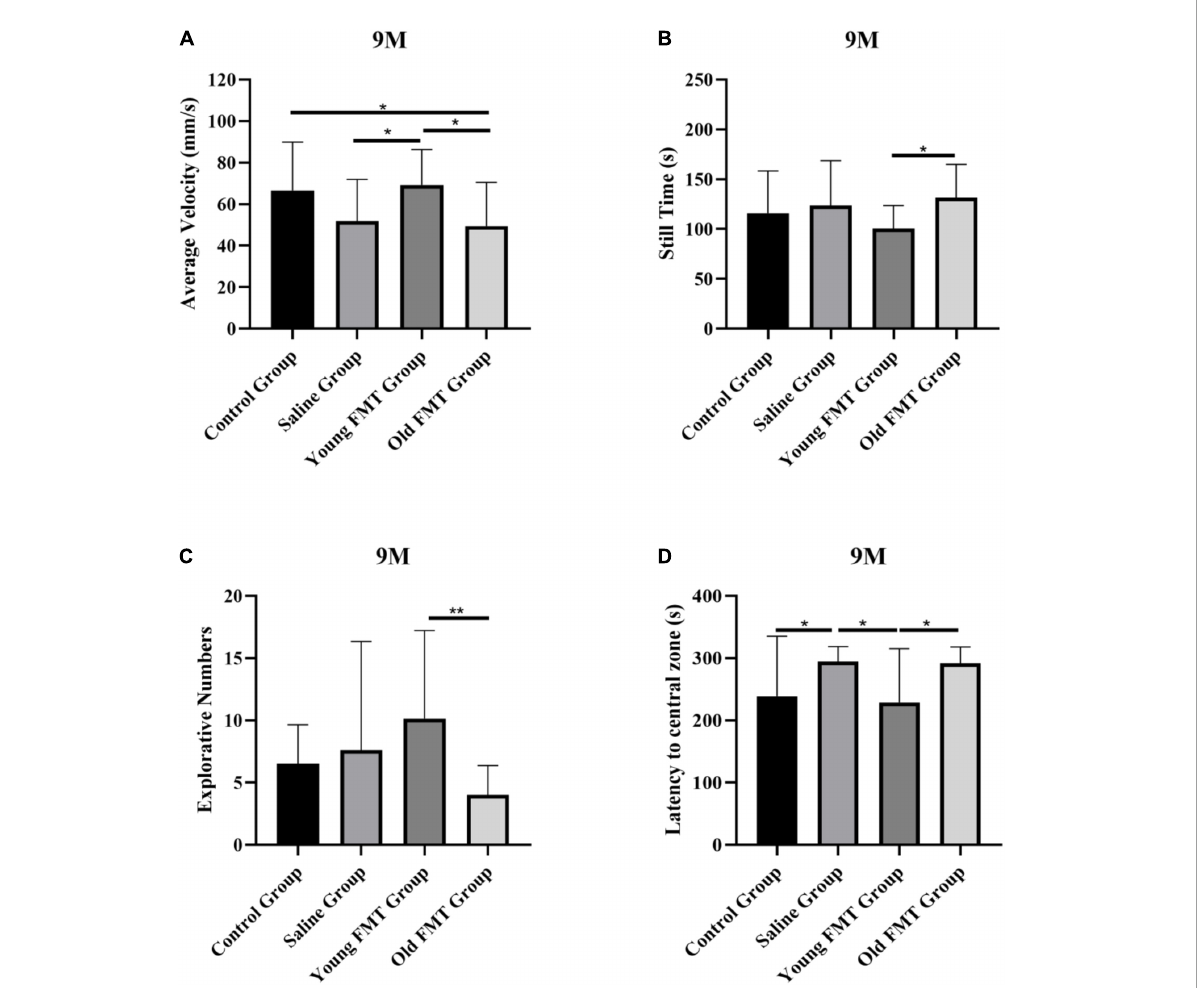
FIGURE2 Effects of fecal microbiota transplantation on locomotor and exploration ability. (A) The average movement speed of Senescence Accelerated Mouse-Prone 8 (SAMP8) mice at 9-month-old in four groups. (B) The still time of SAMP8 mice at 9-month-old in four groups. (C) The exploring times of SAMP8 mice at 9-month-old in four groups. (D) The latency to central zone of SAMP8 mice at 9-month-old in four groups. Control group ( n = 24), Saline group ( n = 20), Young FMT group ( n = 21), Old FMT group ( n = 19). One-way ANOVA. All Data were shown by means ± SD, * P < 0.05, ** P <